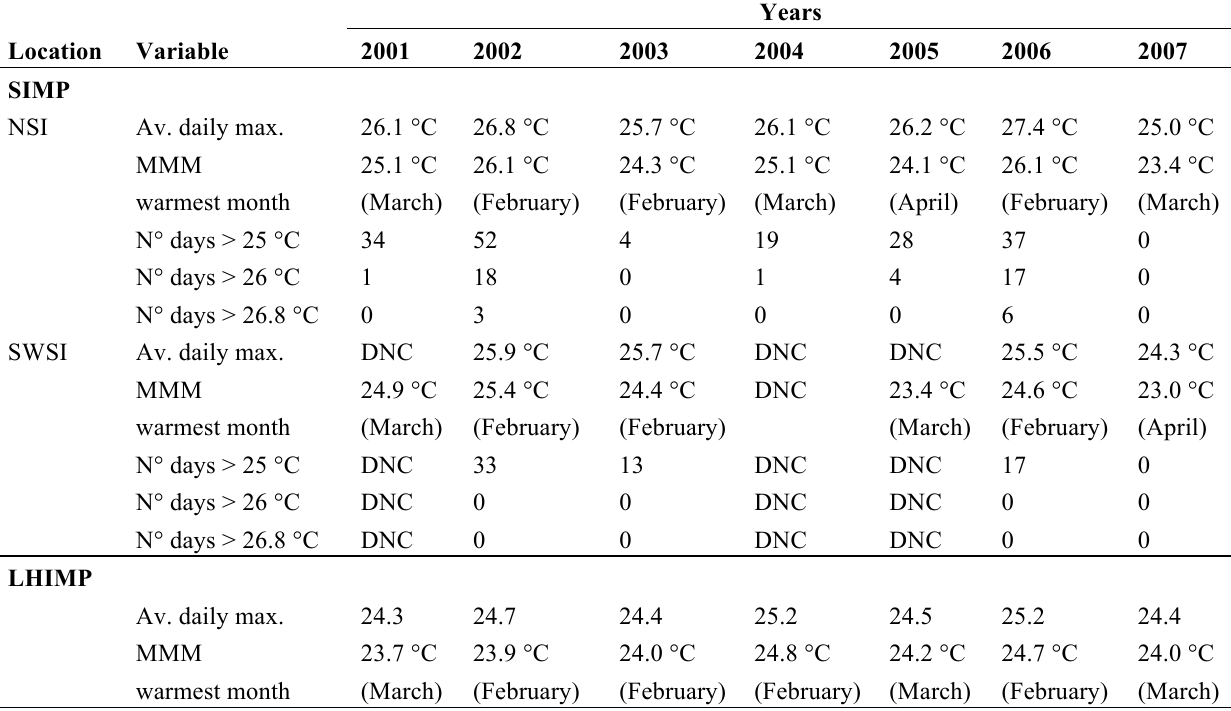
Table 1. Summary of in situ seawater temperature data collected from reefs adjacent to an offshore (North Solitary Island; NSI) and a midshelf (South West Solitary Island; SWSI) island in the SIMP. LHIMP SST data acquired from NOAA climatology [44] are shown in the absence of LHIMP in situ temperature data. DNC = data not complete; MMM = Maximum Monthly Mean. Years